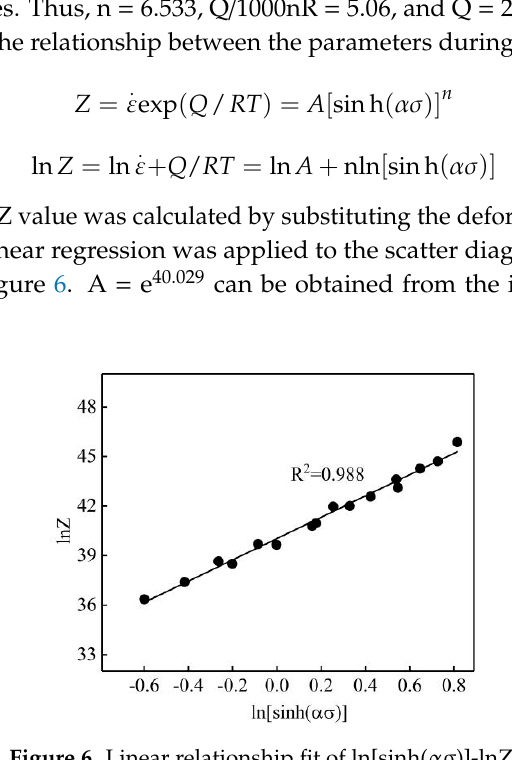
Figure 6. Linear relationship fit of ln[sinh( ασ )]-lnZ.